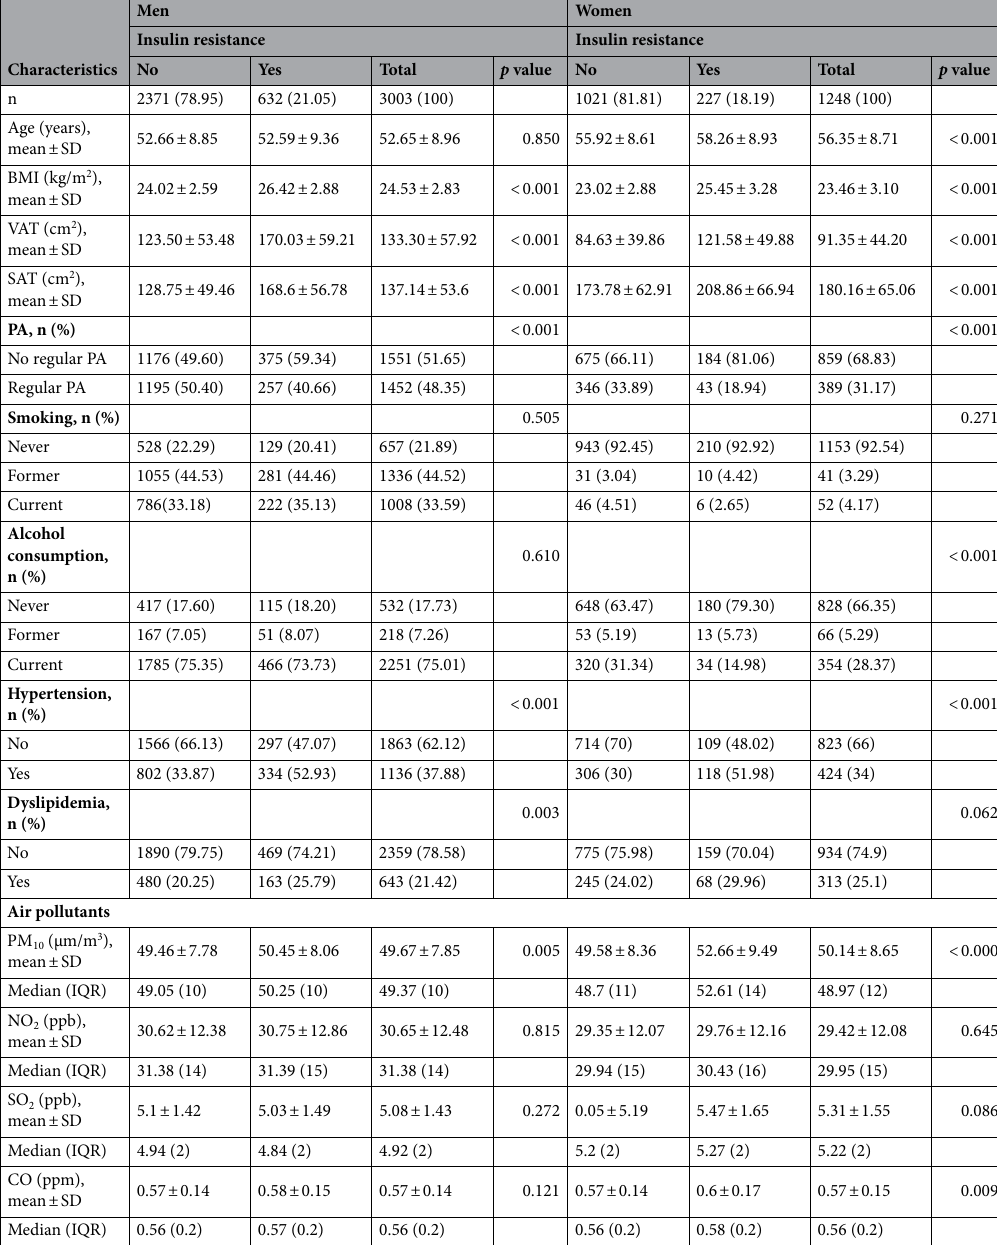
Table 1. Characteristics of the study participants. SD standard deviation, BMI body mass index, VAT visceral adipose tissue, SAT subcutaneous adipose tissue, PA physical activity, PM 10 particulate matter with values were calculated using the chi-squared test for categorical variables and Student’s t test for continuous